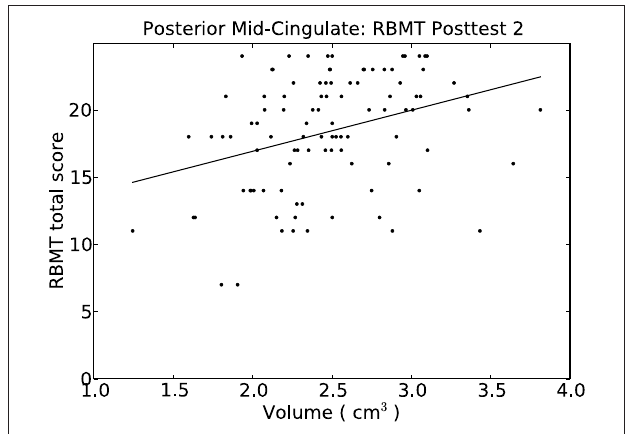
FIgure 4 | relationship between our functionally relevant outcome (rBMT) 1-month post-therapy and the volume of the pMCC. A simple least-squares regression line is plotted. Results from the multiple regression model appears in Table